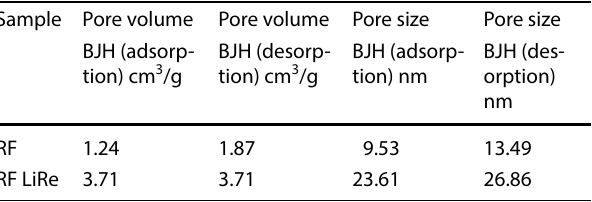
Table 2 Pore volume and pore size calculated for carbon aerogels Sample Pore volume Pore volume Pore size